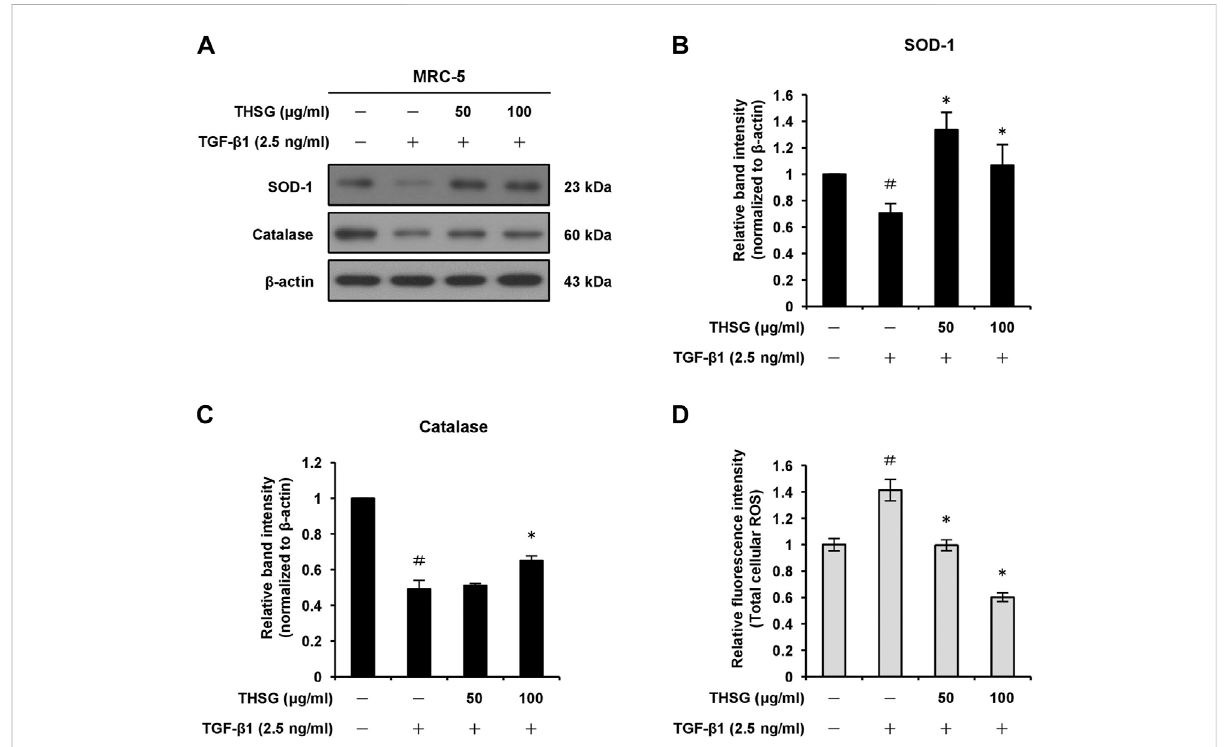
FIGURE 4 Effect of THSG on antioxidative enzymes expression and oxidative stress in TGF- β 1-treated MRC-5 cells. (A) The cells were serum starved for 24 h prior to treatment with various concentrations (50 and 100 μ g/ml) of THSG for 24 h, and then incubated with 2.5 ng/ml of TGF- β 1 for a further 24 h. The protein expression levels of antioxidative enzymes SOD-1 and catalase in whole cell lysates by Western blotting. β -actin was used as a loading control. The relative protein levels of (B) SOD-1 and (C) catalase were quanti fi ed by densitometry and normalized to β -actin. (D) ROS production in cells subjected to different treatment was measured using a ROS detection kit. Data are represented as the mean ± SEM of three independent experiments. # p < 0.05 compared with untreated group. * p < 0.05 compared with TGF- β 1-treated